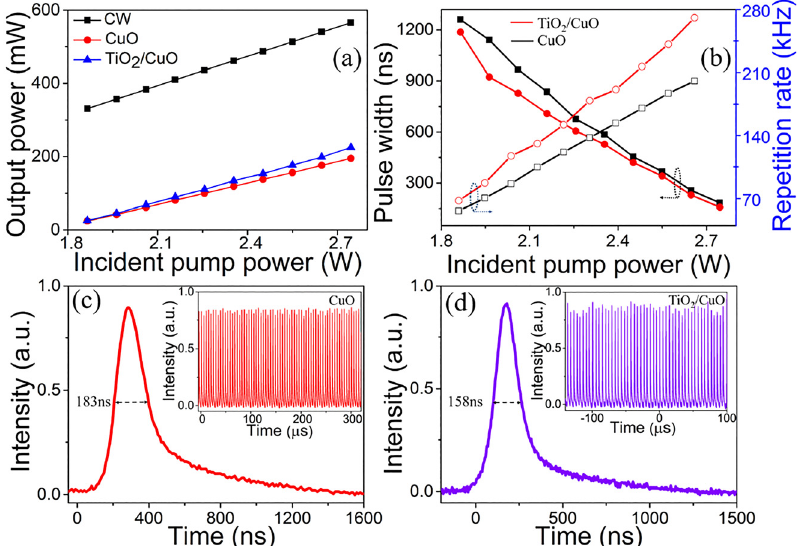
Figure 6: Experimental performances of the passively Q-switched (PQS) lasers with cupric oxide (CuO) and TiO 2 /CuO nano- composites at 1.34 μ m. (a) Continuous wave (CW) and Q-switched average output power. (b) Pulse width and repetition rate versus the incident pump power. (c), (d) Typical Q-switched temporal pulse profile and trains of CuO and TiO 2 /CuO lasers,